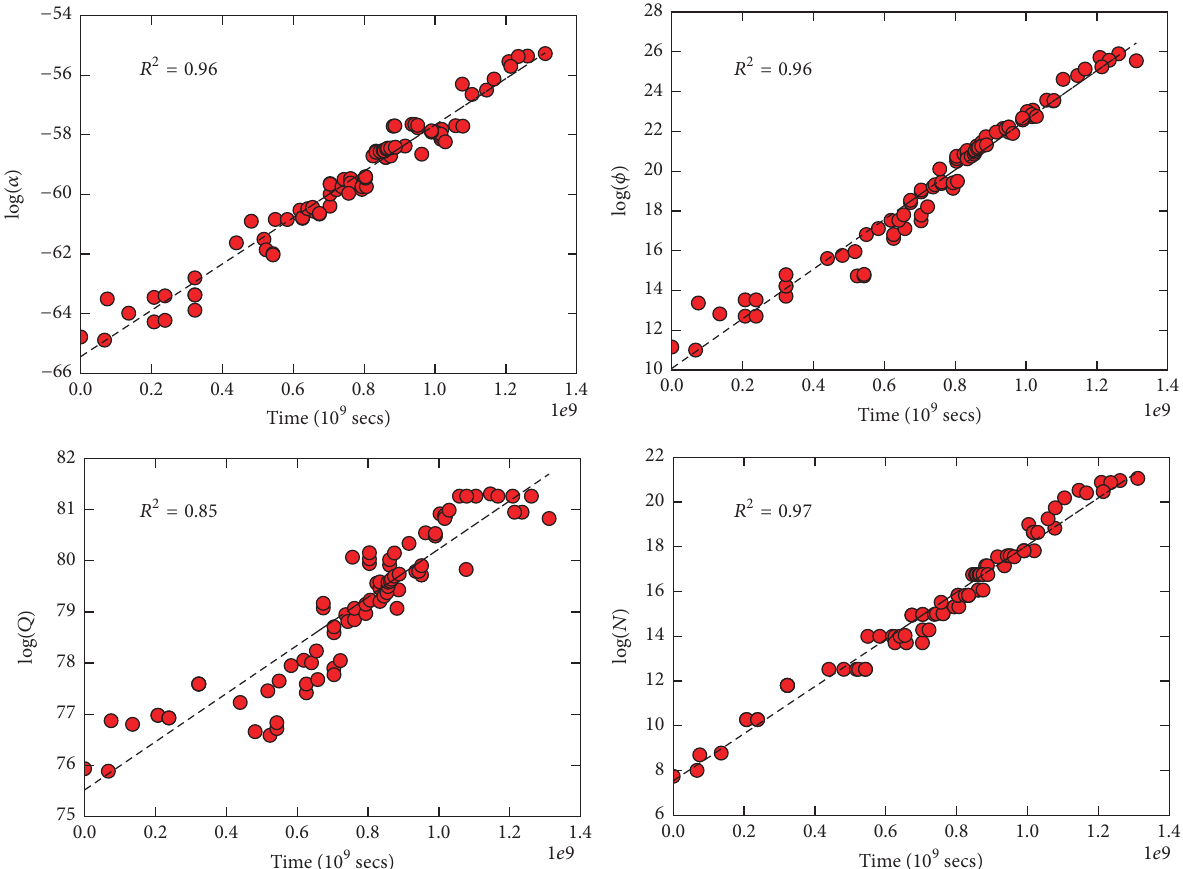
Figure 2: The figure shows the exponential scaling relationships between the characteristics, 𝛼 , 𝜙 , 𝑄 , and 𝑁 , with respect to time on a semilogarithmic scale (see (9)) with the goodness of fit (inset).